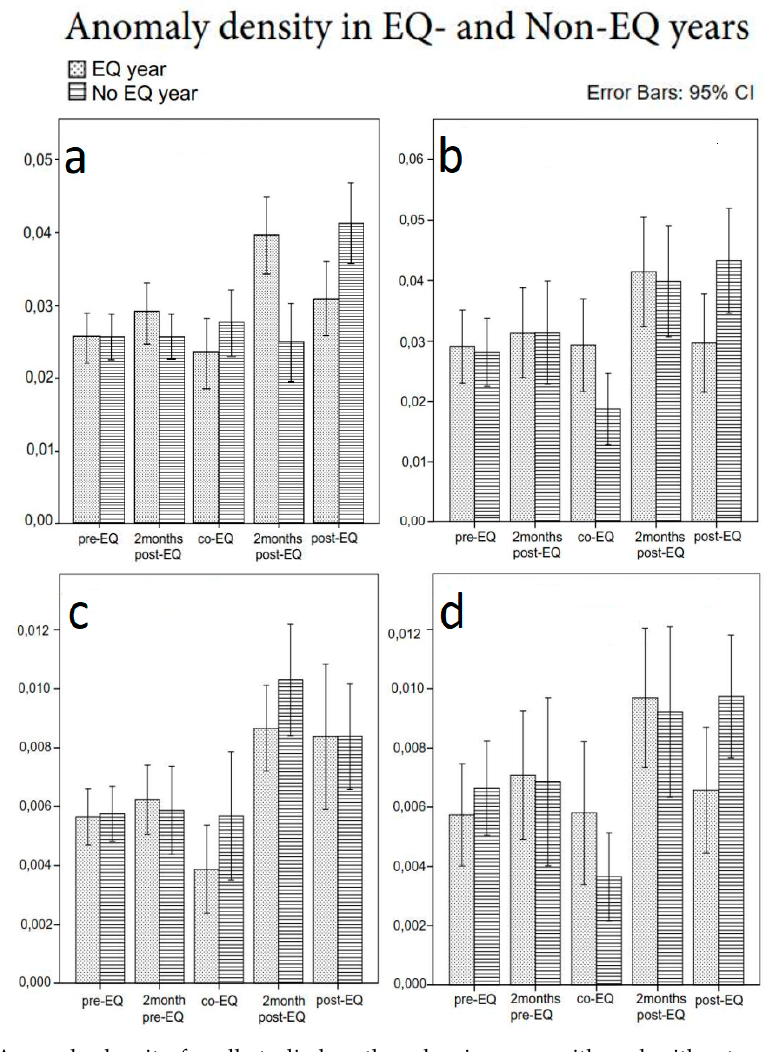
Figure 5. Anomaly density for all studied earthquakes in years with and without an earthquake, summarized by period. Results are shown for all different configurations: ( a ) detection using µ + 2 σ threshold, 48-h co-seismic period; ( b ) detection using µ + 2 σ threshold, adjusted co-seismic period; ( c ) detection using µ + 3 σ threshold, 48-h co-seismic period and ( d ) detection using µ + 3 σ threshold, adjusted co-seismic period.